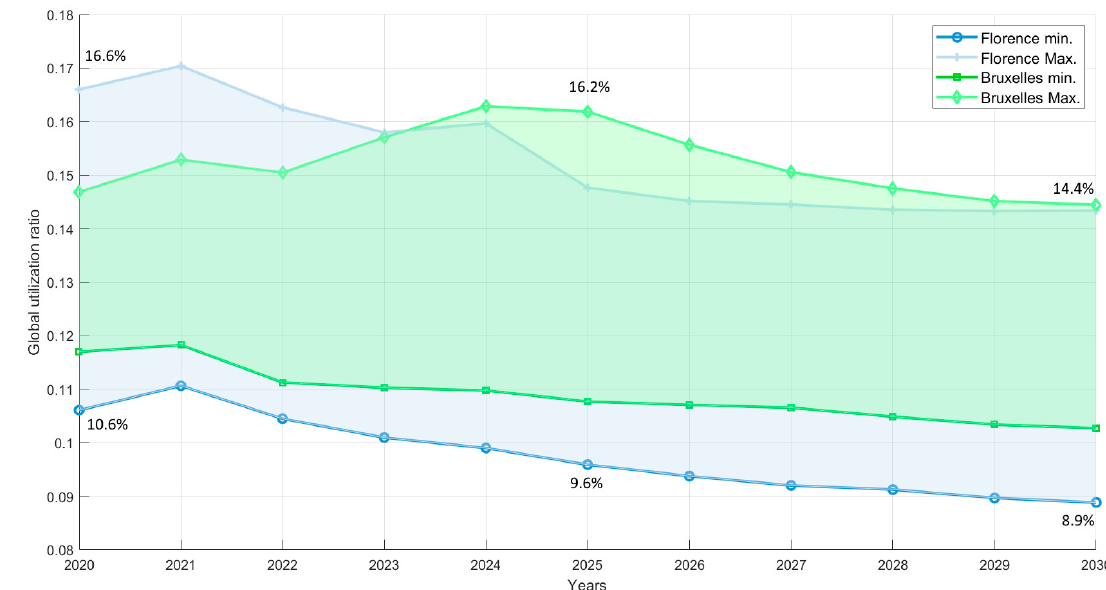
Figure 12. Publicly accessible charging infrastructure utilization rate for Florence (light blue) and Bruxelles (light green).